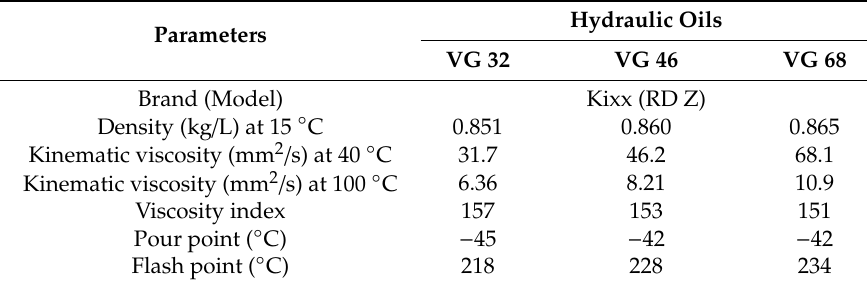
Table 3. The specifications of the hydraulic oils used in this